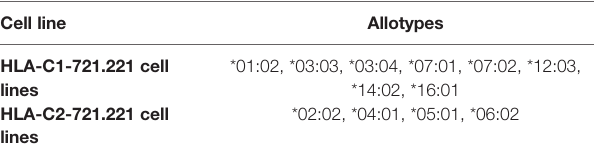
TABLE 1 | Overview of generated HLA-C expressing 721.221 cell